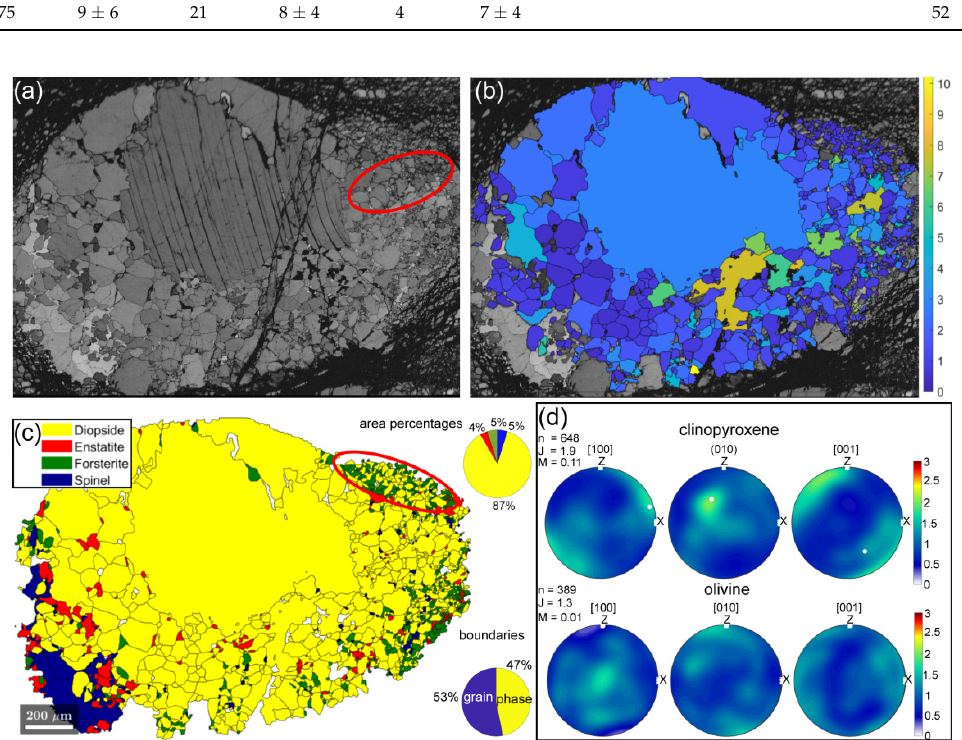
Figure 6. ( a ) Band contrast image of a recrystallized cpx porphyroclast (ROI12). The red circle shows an area with fine-grained layers in between larger grains. ( b ) Grain orientation spread (GOS) map of diopside, displaying the internal misorientation of the grains. ( c ) Phase map. The red circle shows mixed olivine and cpx domains at the border of the clast. ( d ) Clinopyroxene and olivine CPO. The map of smaller cpx porphyroclasts (Figure 7) shows olivine grains directly at the porphyroclast border, and in contrast to the other two analyzed porphyroclasts, it has a relatively high proportion (63%) of phase boundaries. The phase mixture consists of 66% cpx and 33% olivine, with a small amount of spinel (1%) and opx (<1%). The recrystallized opx grain sizes are smaller (average 11 µm ± 9 µm) for this cpx porphyroclast than for the other two cpx porphyroclasts (Table 1). The grain size is similar to the olivine grain size (10 ± 6 µm, Table 1). The clinopyroxenes show a weak CPO related to the host orientation. No olivine CPO is observed (Figure 7).